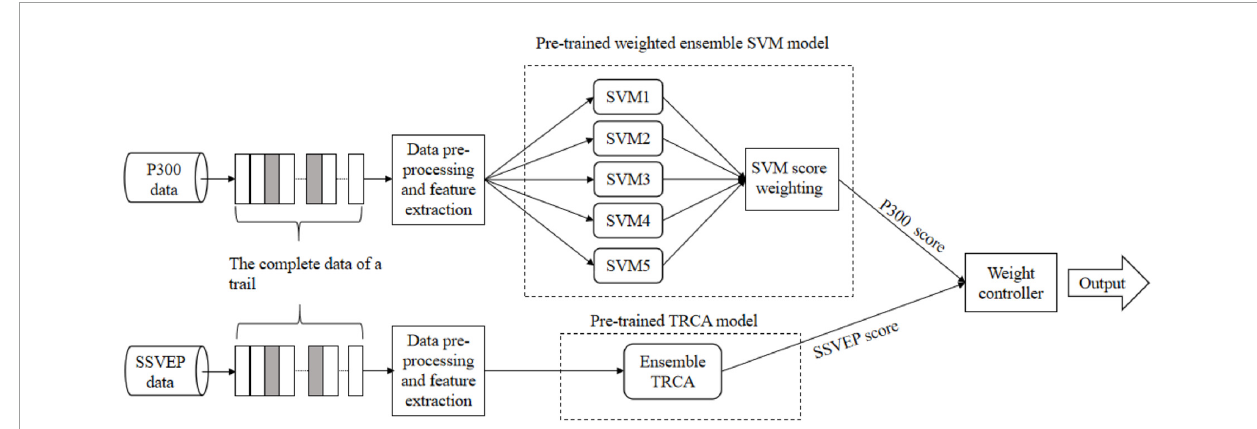
FIGURE3 The data processing process for a single trial in the hybrid speller system. The gray blocks in the data section indicate target stimuli, and the white blocks indicate non-target stimuli. The two models and one weight controller are pre-trained by the calibration data.